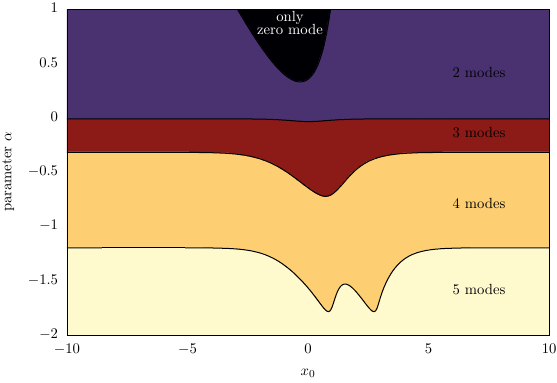
Figure 4 . Number of discrete modes (zero mode and oscillating modes) in the (cid:30) 4 BPS-impurity model (4.11) as a function of the impurity strength (cid:11) and the position on the moduli space x 0 .